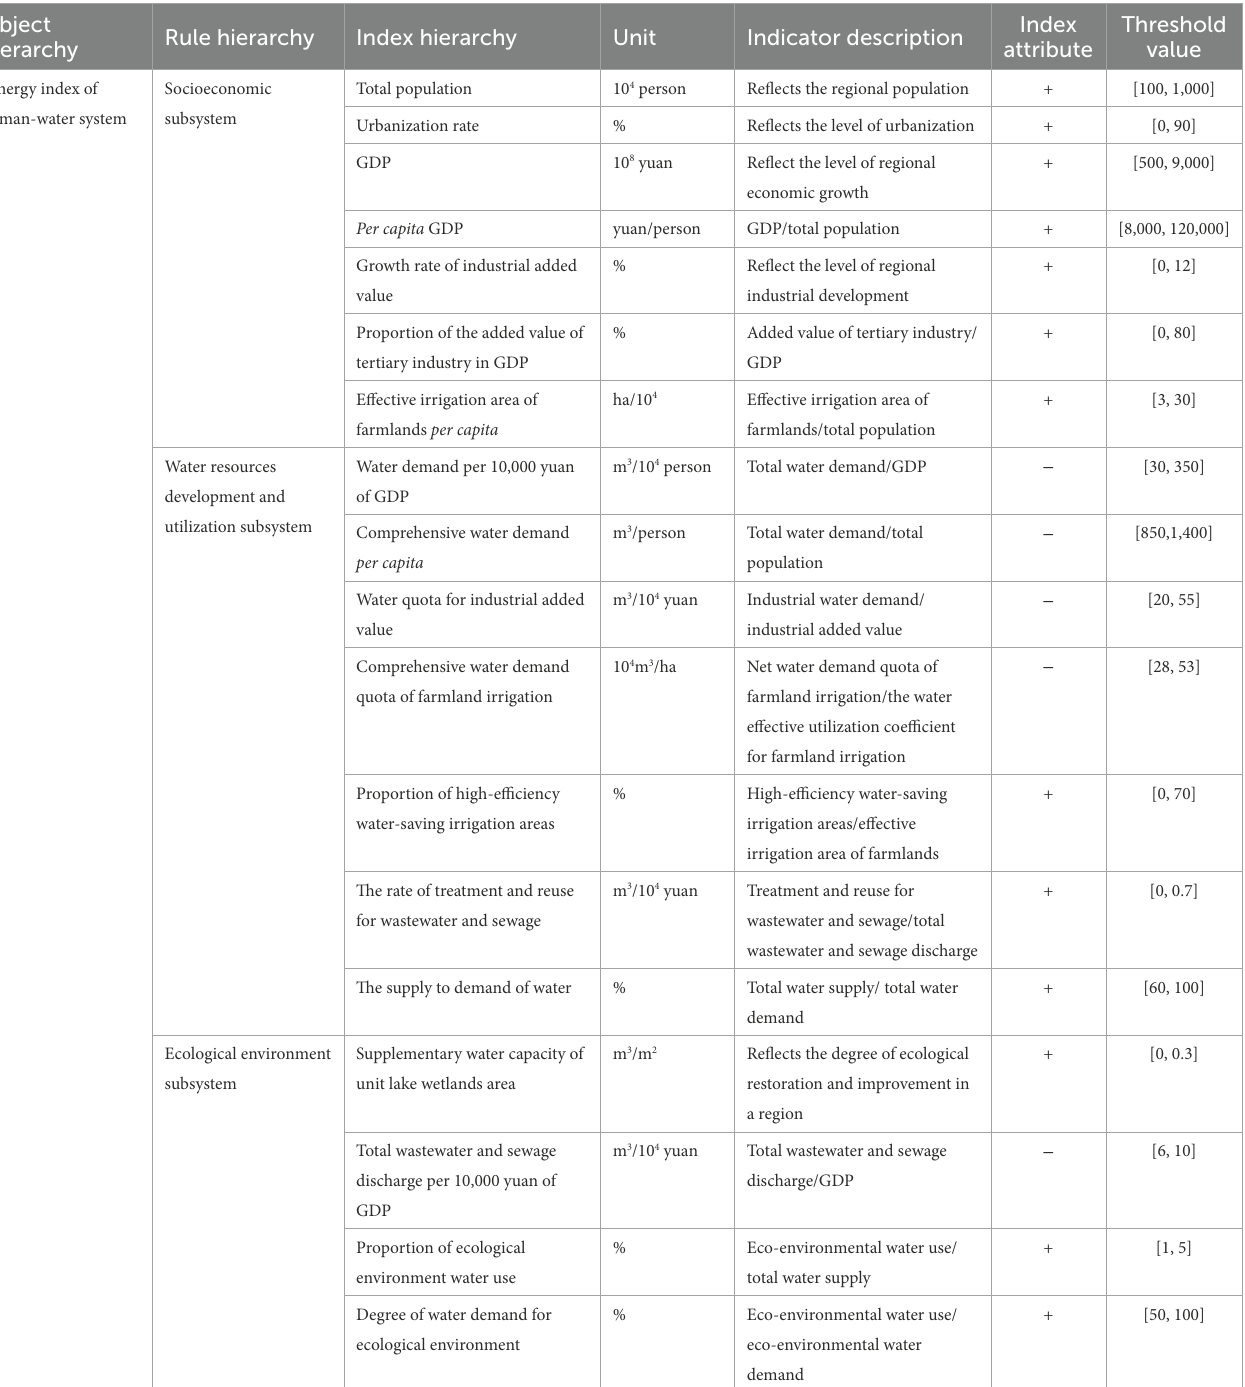
TABLE 2 Indicator system of human-water system coevolution